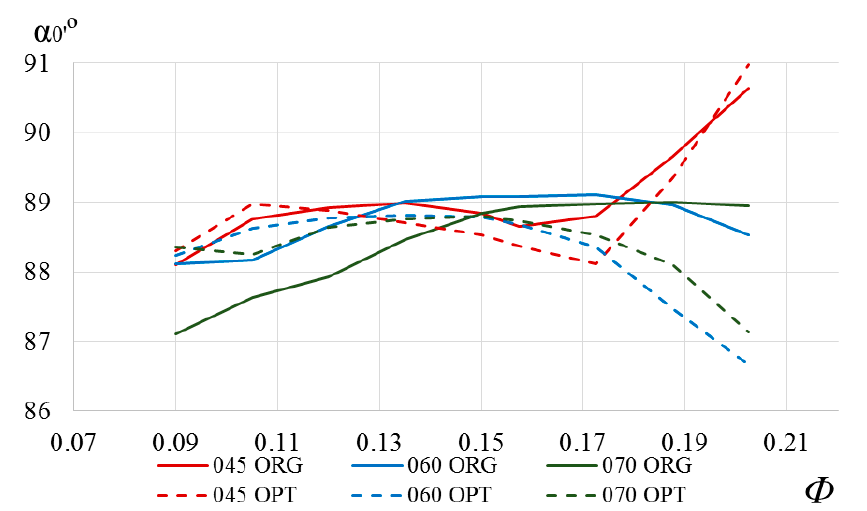
Ф = 0.15 and different loading des